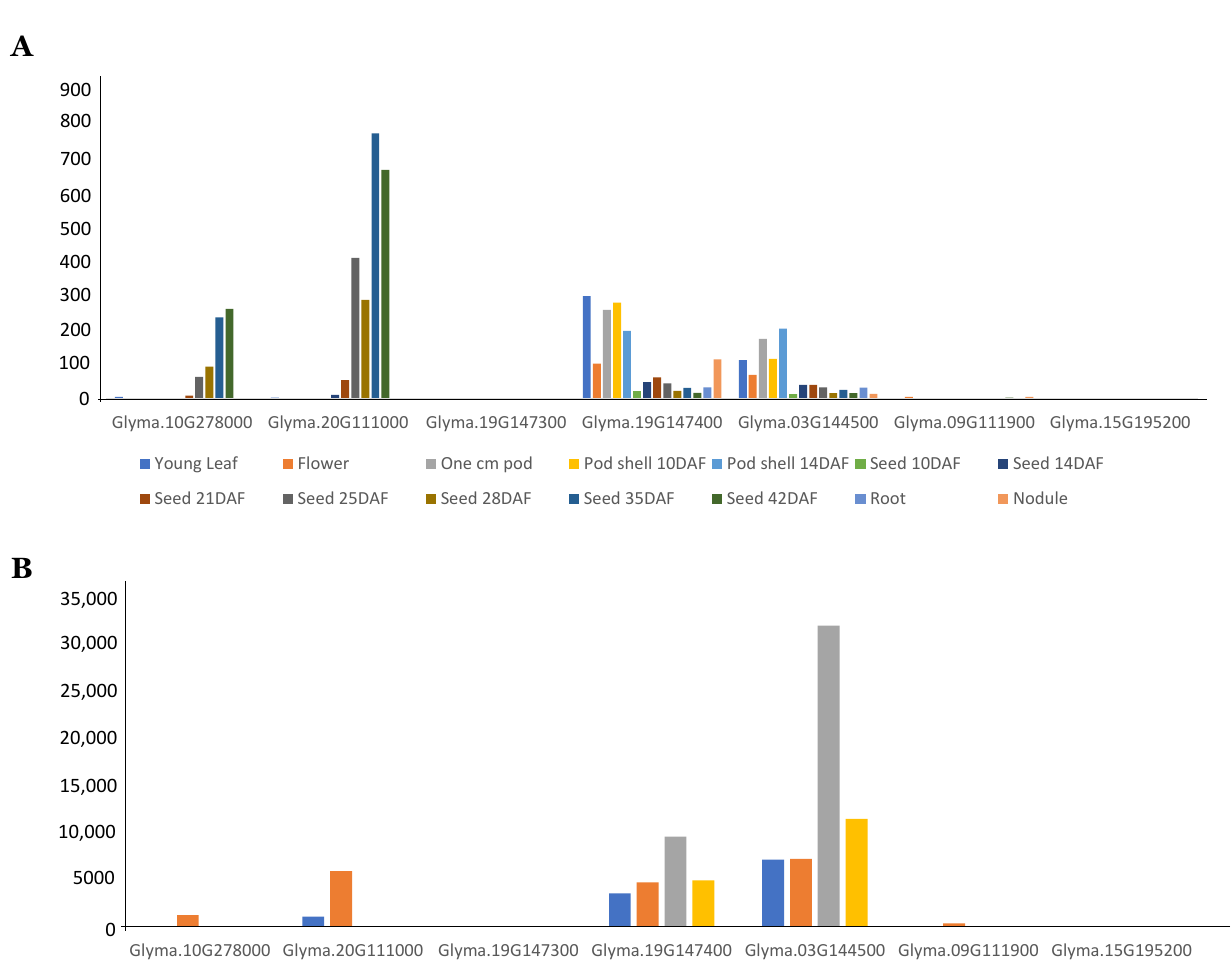
Figure 2. Expression pattern of soybean GmFAD2-1 and GmFAD2-2 gene members. ( A ) Expression of the seven GmFAD2 members in Williams 82 were retrieved from publicly available RNA-seq data from the SoyBase (http://www.soybase.org/ soyseq), in addition to ( B ) the RNAseq data from the cultivar